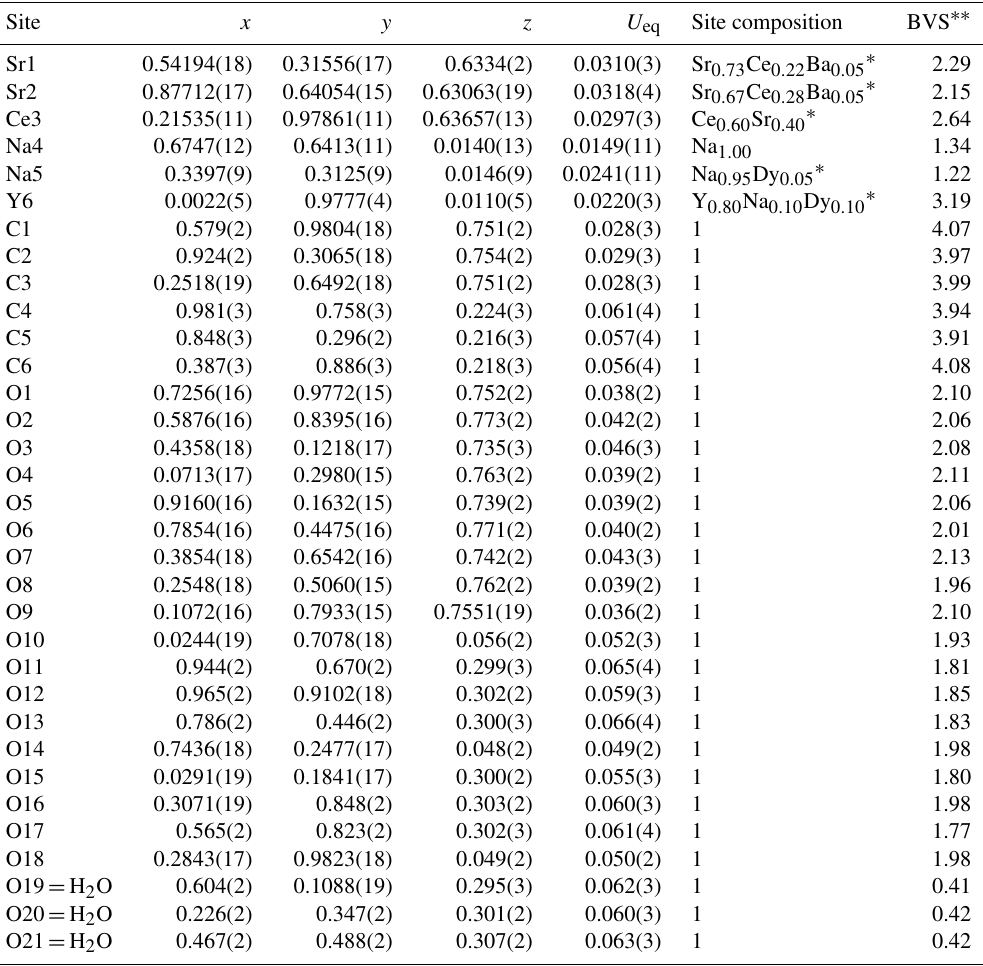
Table 4. Coordinates and equivalent displacement parameters ( U eq , in Å 2 ) of atoms, site occupancies, and bond valence sums (BVSs) for